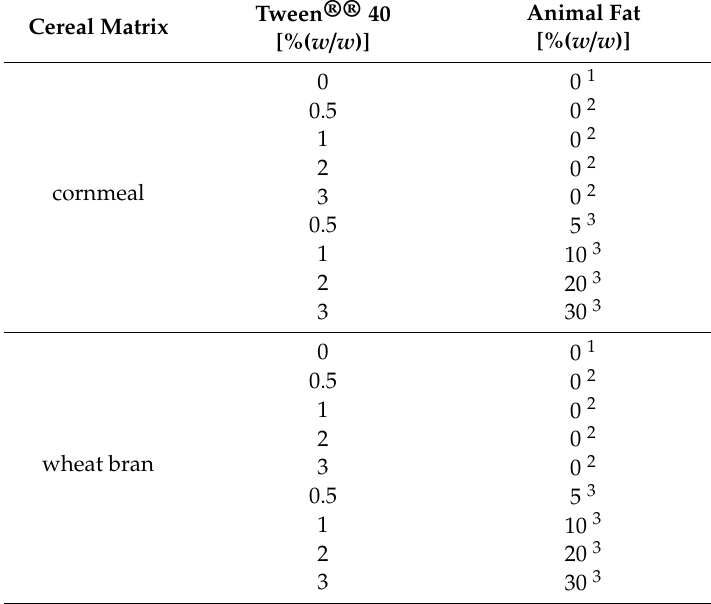
Table 2. Amount of added Tween ®® 40 and animal fat to cereal matrixes used for the solid-state fermentation by Mortierella alpina. Animal Fat Tween ®® 40 Cereal Matrix [%( w / w )] [%( w / w )] 0 0 1 0.5 0 2 1 0 2 2 0 2 cornmeal 3 0 2 0.5 5 3 1 10 3 2 20 3 3 30 3 0 0 1 0.5 0 2 1 0 2 2 0 2 wheat bran 3 0 2 0.5 5 3 1 10 3 2 20 3 3 30